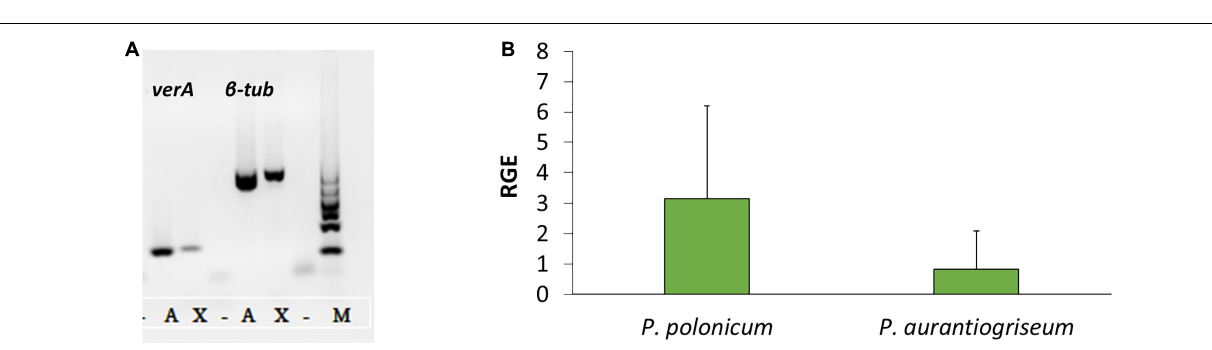
FIGURE 2 | Presence and expression of verA gene in Penicillium spp. Amplification of verA and β -tubulin genes from gDNA (A) : X, P. polonicum X6; A, P. aurantiogriseum CBS121001; M, GelPilot 100 bp Ladder; –, negative control (PCR mix without DNA). Relative gene expression (RGE) of verA ( cl4A ) gene in P. polonicum and P. aurantiogriseum (B) was evaluated 10 days post inoculation on CYB. The expression is relative to the expression of the β -tubulin gene, and P. aurantiogriseum was used as reference strain.